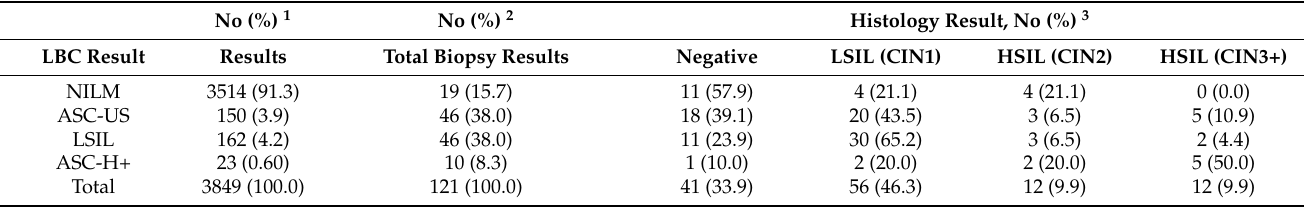
Table 5. Biopsy results with preceding LBC